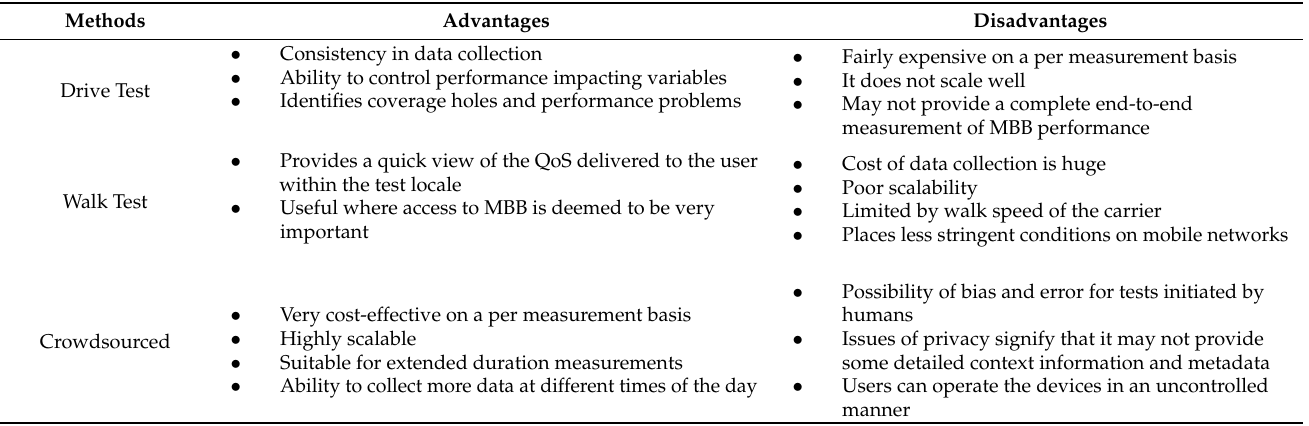
Table 6. Advantages and disadvantages of mobile broadband measurement